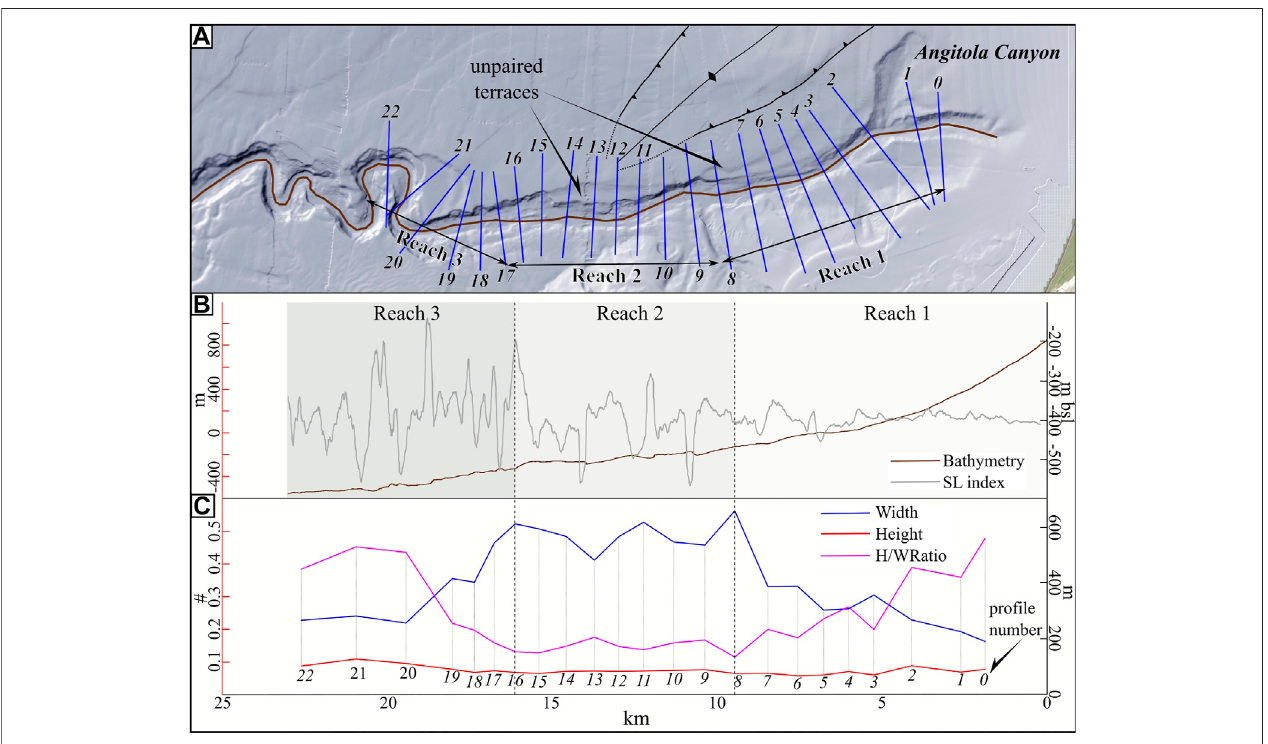
FIGURE 9 | A) Map view of the upstream portion of the Angitola Canyon. In black, the southern part of the Maida Ridge. In blue, the location of 23 bathymetric cross-pro fi les. In brown, the trace of the thalweg. The three double-arrowed black lines show the length of the three reaches. (B) The brown line and the black vertical axisrelatetothelongpro fi leoftheAngitolaCanyon,whilethegreycurveandtheredverticalaxisrepresenttheSLindexcomputedvalues. (C) Inredandblue,thecanyon height and width curves, respectively; both curves refer to the black vertical axis. In magenta, the H/W ratio curve which values relate to the red vertical